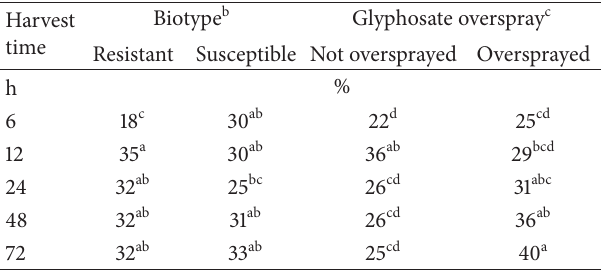
Table 1: Absorption of 14 C-glyphosate as affected by Palmer ama- ranth biotype and glyphosate overspray a